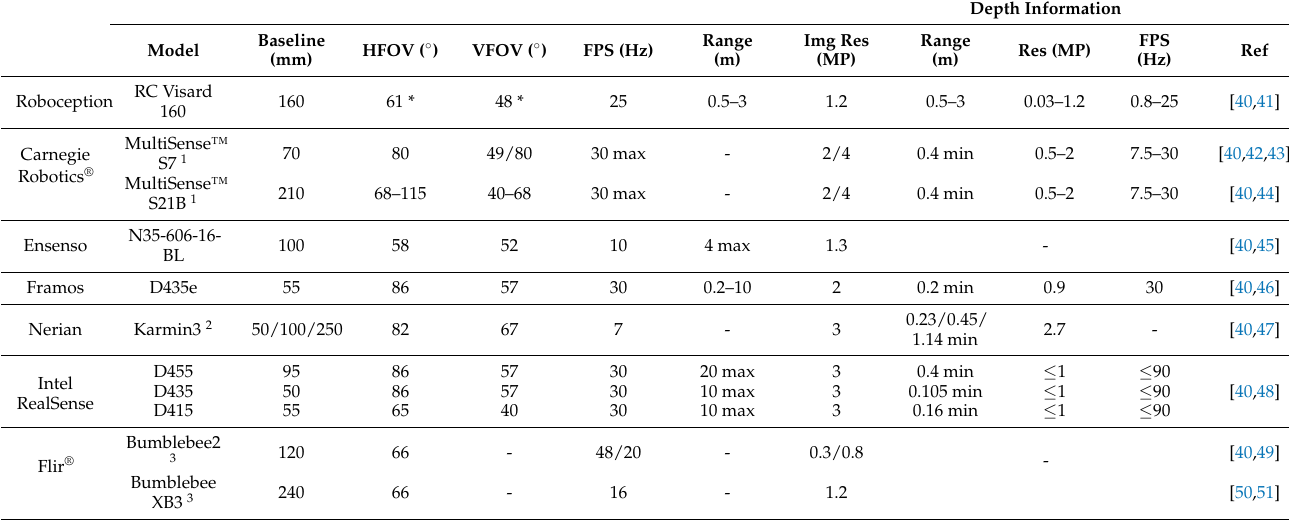
1 HFOV, VFOV, image resolutions, image frame rates and depth information depend on the variant of focal length (optical lens geometry). 2 Specifications stated are in full resolution and monochrome, focusing on the standard 4 mm lens. 3 Offers either 2.5 mm, 3.8 mm or 6